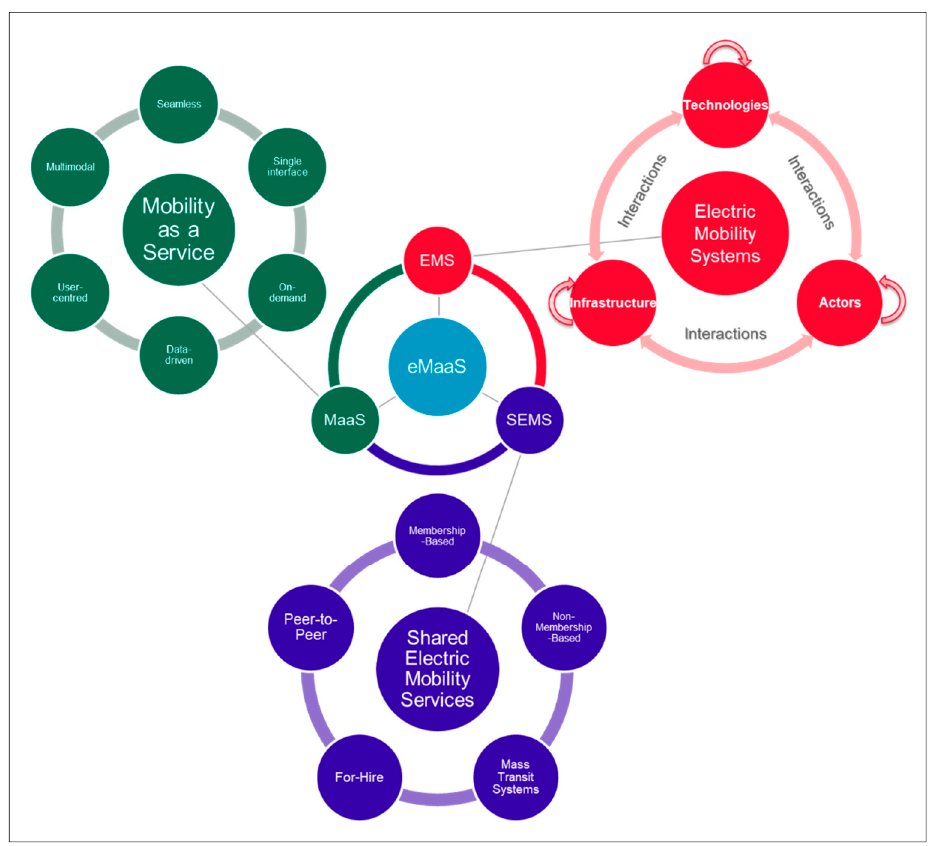
Figure 3. The electric Mobility as a Service (eMaaS) ecosystem. Note: The top-right side of this figure is an adaptation from the EMS model by Abdelkafi et al. [14].